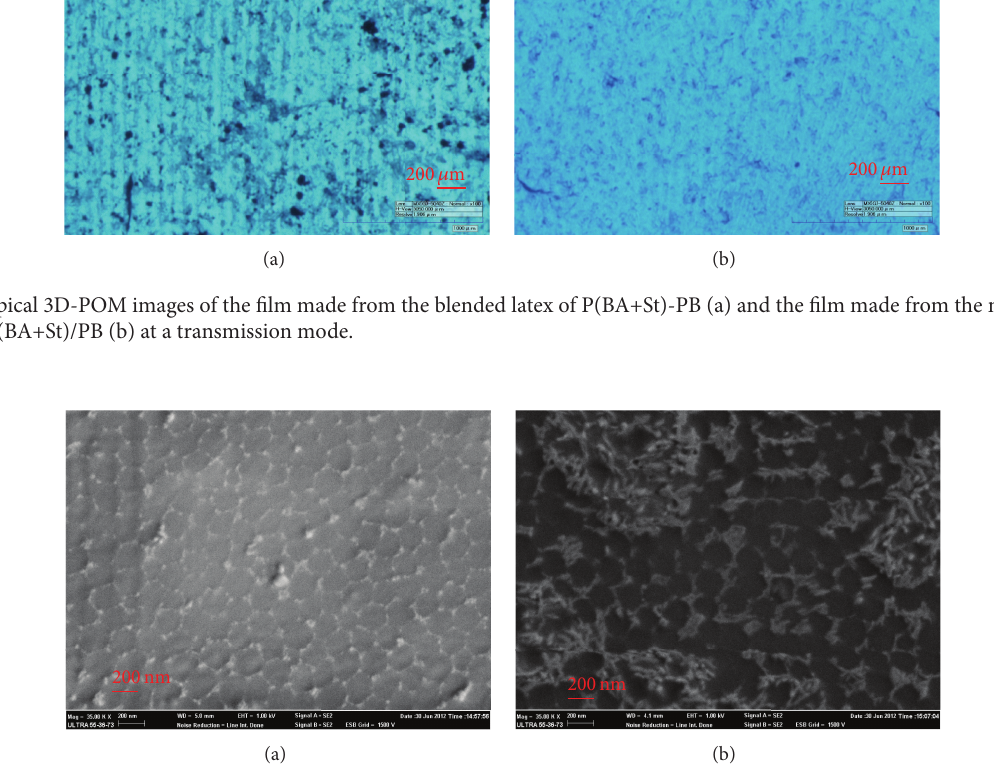
Figure 5: Typical FESEM images of the film surfaces made from the latex of the P(BA+St)/PB nanocomposites (a) and the blended latex of P(BA+St)-PB